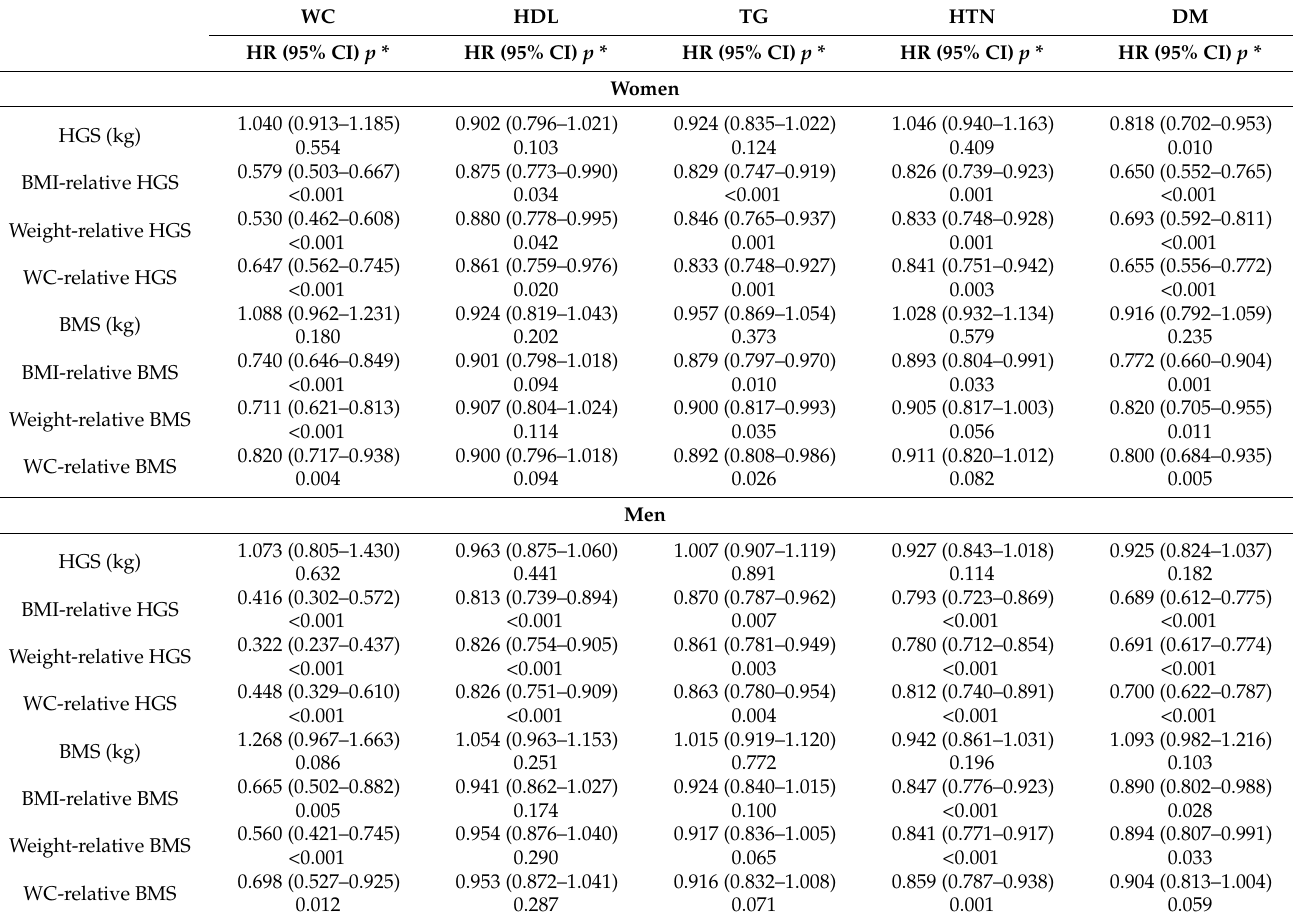
Table 6. Adjusted hazard ratio (HR) of incident metabolic syndrome components associated with one standard deviation increase in mean hand grip strength, back muscle strength, and relative muscle strength according to